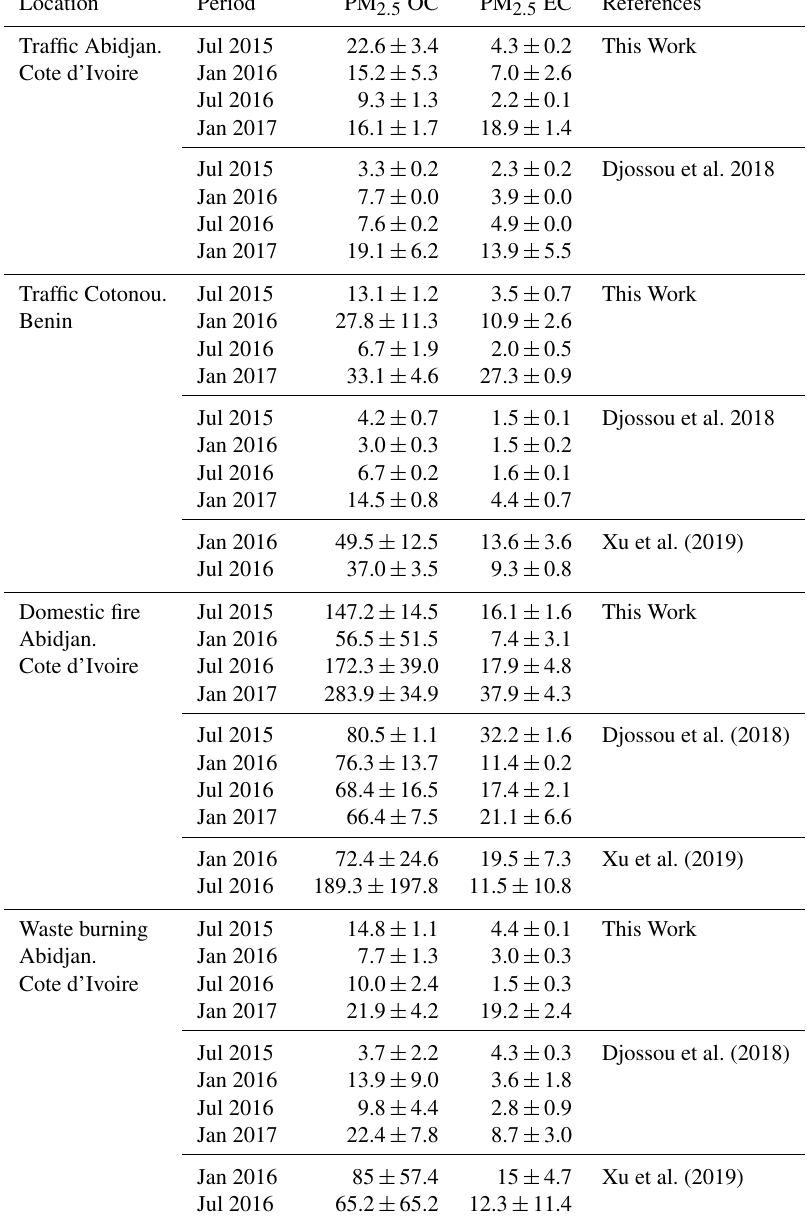
Table 5. PM 2 . 5 –EC and PM 2 . 5 –OC comparison with Djossou et al. (2018) and Xu et al. (2019) values. Units are in micrograms of carbon per cubic meter (µgCm − 3